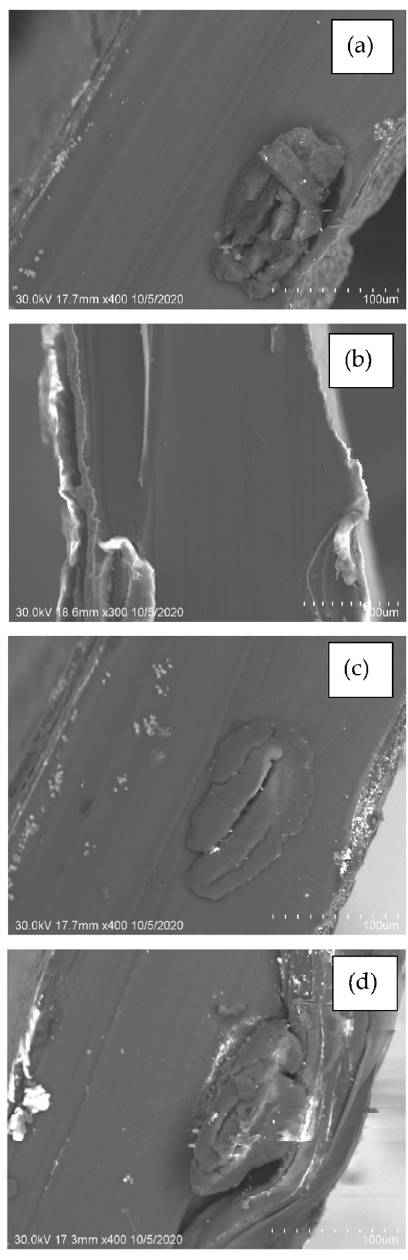
Figure 2. SEM images of ( a ) N438, ( b ) N438 coated with Ag, ( c ) N438 coated with Ag-CNT and, ( d ) N438 coated with Ag-Graphene Energy dispersive spectroscopy (EDS) analysis.